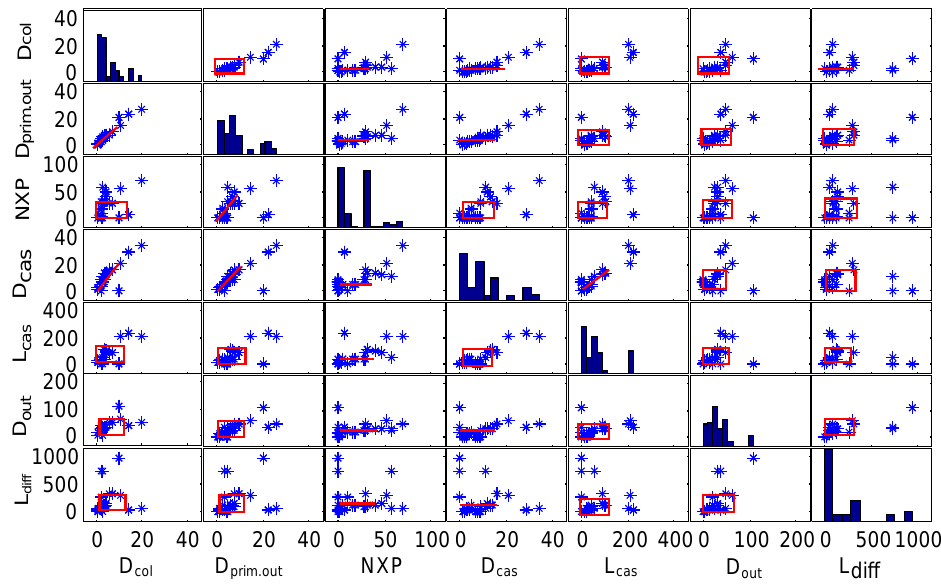
Figure 12. Scatter plot matrix of input data concerning geometric characteristics. Rectangles and lines show the range of optimum